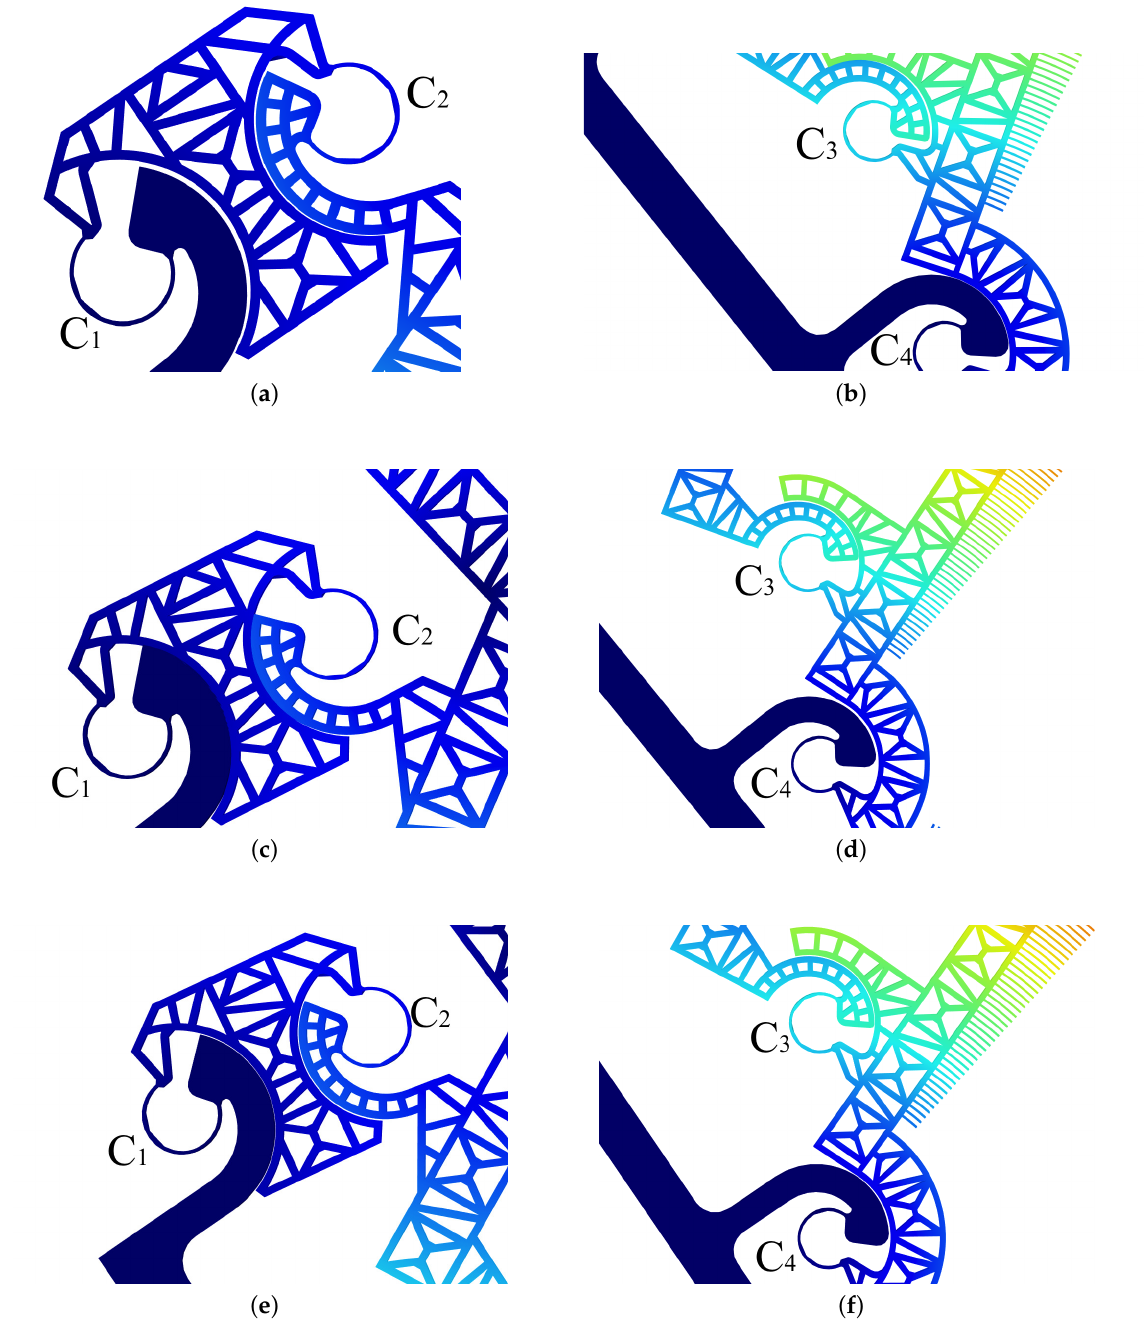
Figure 7. Configurations of CSFHs with | F | = 1 × 10 − 5 (N): ( a ) C 1 and C 2 at ϕ = 50 ◦ ; ( b ) C 3 and C 4 at ϕ = 50 ◦ ; ( c ) C 1 and C 2 at ϕ = 180 ◦ ; ( d ) C 3 and C 4 at ϕ = 180 ◦ ; ( e ) C 1 and C 2 at ϕ = 280 ◦ ; ( f ) C 3 and C 4 at ϕ = 280 ◦